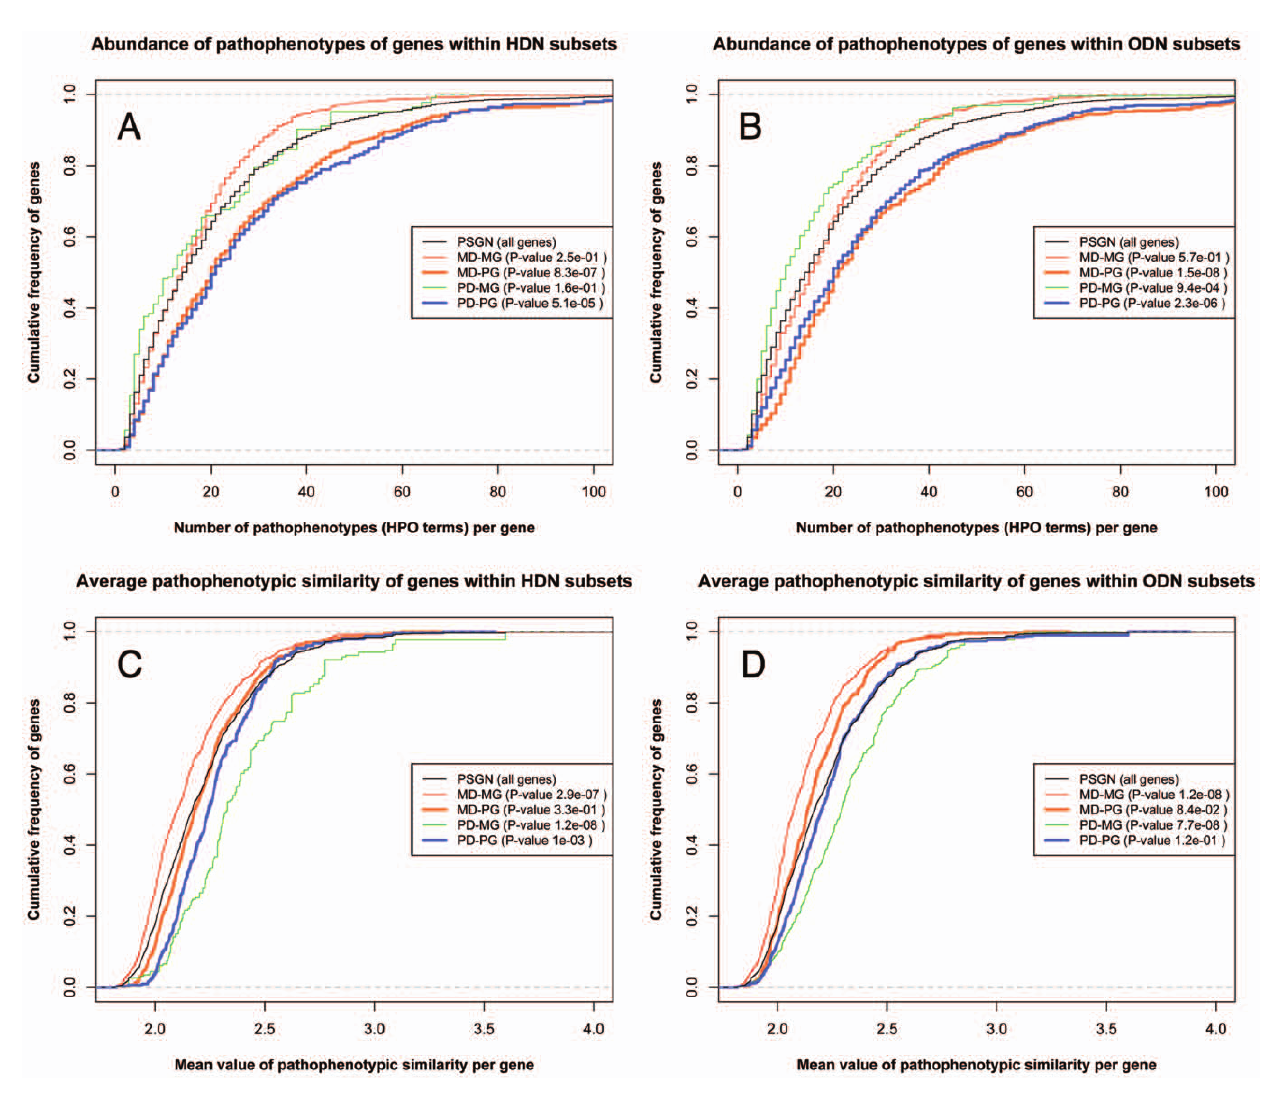
Figure 5. Distributions of the number of pathophenotypes and pathophenotypic similarities in each subset. MD-MG (red line), MD-PG (orange line), PD-MG (green line), PD-PG (blue line) and PSGN (Black line). Upper panels represent the cumulative frequency of the number of specific pathophenotypes annotated for genes in HDN (C) and ODN (D) subsets, the whole set of genes in HPO (PSGN) was used as the reference distribution. Lower panels represent the cumulative frequency of the average pathophenotypic similarity associated with genes in HDN (C) and ODN (D) subsets, the whole set of genes in HPO (PSGN) was used as the reference distribution. The p-values, included in each legend, represent the mean of the resulting p-values after 1000 non-parametric tests (Mann-Whitney test) where each subset was compared, each time, with a random sample of the pathophenome of the same size of the subset (see methods).